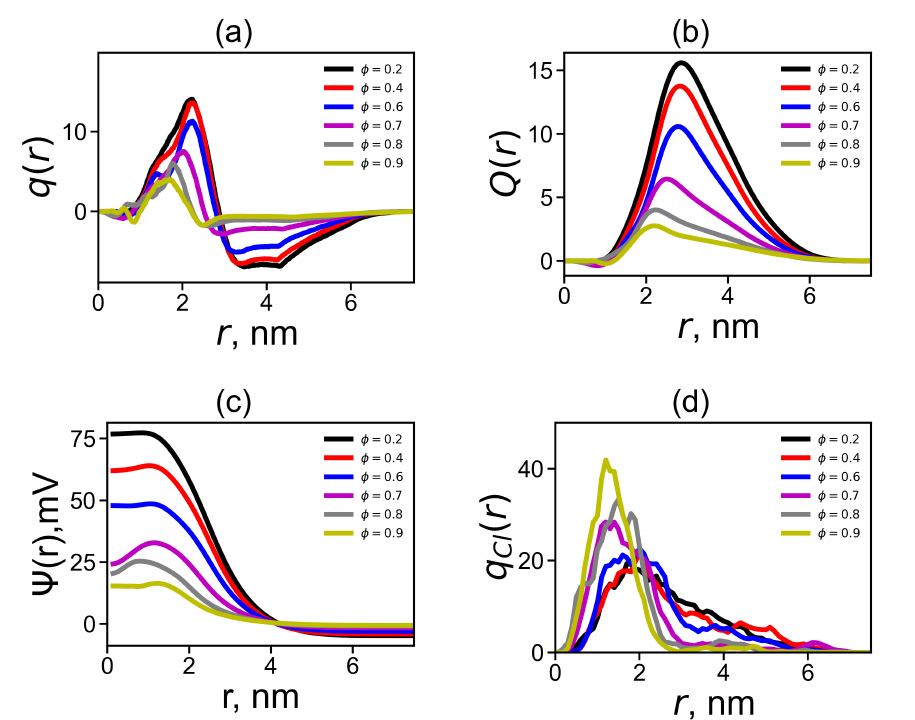
Figure 8. The radial distribution for DGL2 of ( a ) the total charge q ( r ) , ( b ) the cumulative charge Q ( r ) , ( c ) the electrostatic potential Ψ ( r ) , and ( d ) the distribution q Cl ( r ) of the counterion